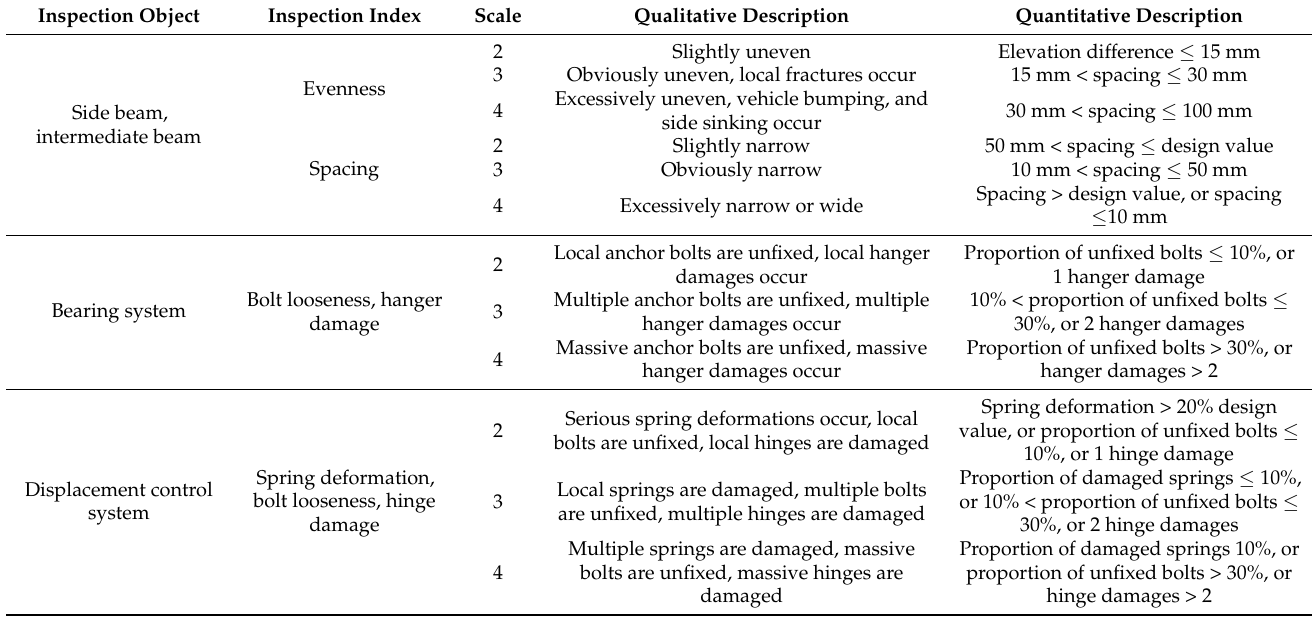
Table 3. Inspection index evaluation the BECI of MB modular